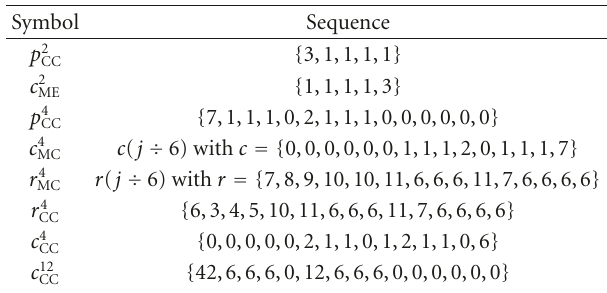
Table 2: Production and consumption sequences instantiated for a resolution of 80 × 48